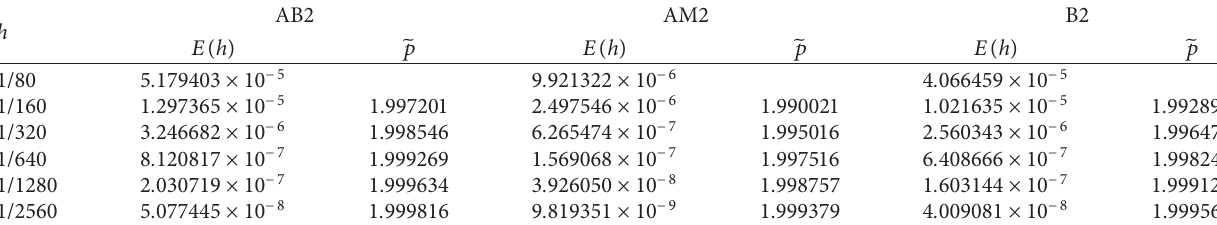
Table 1: The maximum global errors E ( h ) and the observing orders 􏽥 p produced by AB2, AM2, and B2 when applied to equation (81). h